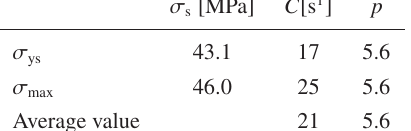
Table 2. Coe ffi cient of Cowper-Symonds equation for PLLA / PCL = 80 / 20.